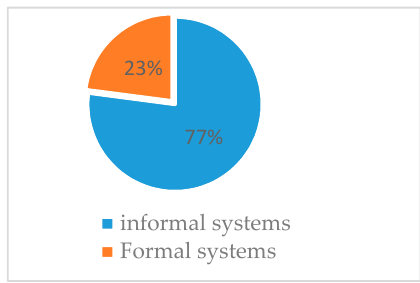
Figure 5. Proportion of households practicing both technologies.